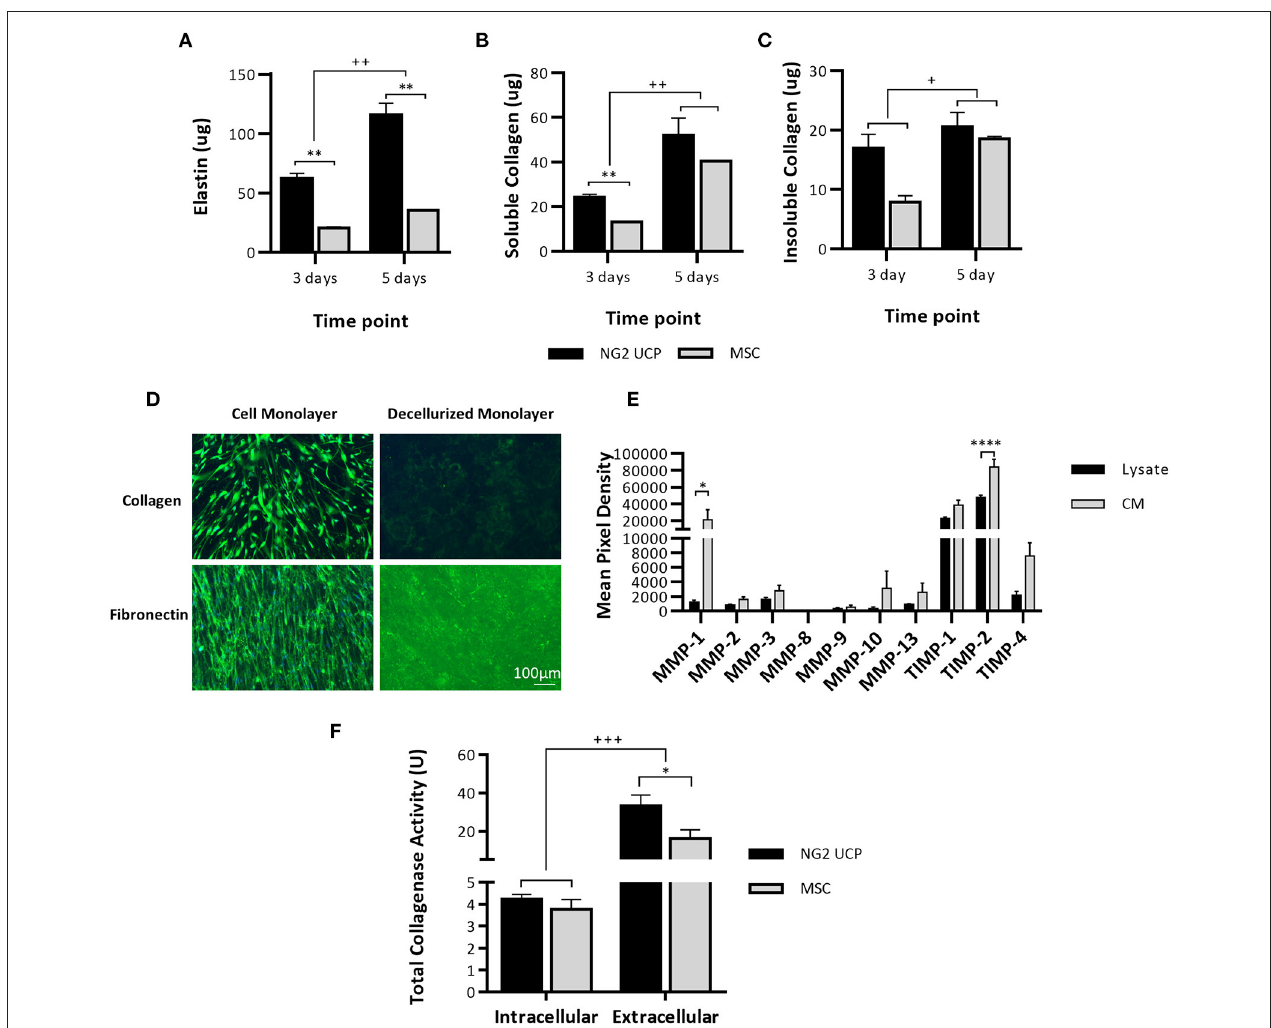
FIGURE 7 | NG2 UCPs produce ECM proteins. (A) Quantification of elastin in confluent cell monolayers. (B) Quantification of pepsin acid-soluble collagen in confluent cell monolayers and CM. (C) Quantification of insoluble collagen in confluent cell monolayers. For (A–C) , data represent means ( ± S.E.M). MSCs and NG2 UCPs, n = 2 and 6 biological replicates, respectively. * / + p < 0.05 and ** / ++ p < 0.01. * represents differences between cell types, + represents differences between time points. (D) Presence of extracellular proteins collagen and fibronectin in decellularized monolayers. (E) Relative MMP levels in NG2 UCP lysate and CM. Data represent means ( ± S.E.M), n = 4 biological replicates; * p < 0.05 and **** p < 0.0001. (F) Total intracellular (total protein) and extracellular (CM) collagenase activity in NG2 UCPs and MSCs per T25 culture flask. Data represent means ( ± S.E.M). MSCs and NG2 UCPs, n = 4 and 6 biological replicates, respectively. * / + p < 0.05 and *** / +++ p < 0.001. * represents differences between cell types, + represents differences between intracellular and extracellular activity.